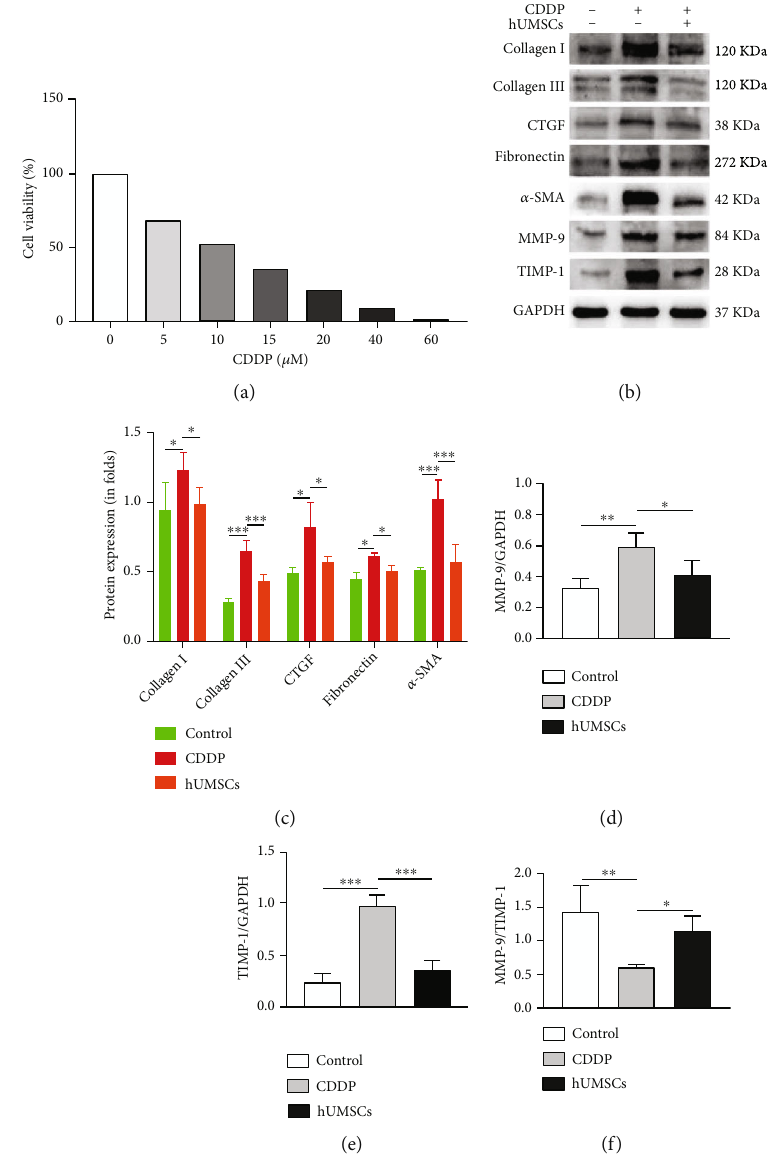
Figure 6: Fibrosis, MMP-9, and TIMP-1 expressions in hEnSCs. (a) Cell viability of hEnSCs as determined in response to varying concentrations of CDDP. (b) Expressions of Collagen I, Collagen III, CTGF, Fibronectin, α -SMA, MMP-9, and TIMP-1 in hEnSCs within each group. A representative blot from one of the three independent experiments performed is shown. GAPDH was used as the loading control. (c) Levels of Collagen I, Collagen III, CTGF, Fibronectin, and α -SMA within each group. (d – f) Levels of MMP-9, TIMP- 1, and MMP-9/TIMP-1 ratio within each group. Data are presented as the means ± SDs . ∗ P < 0 : 05, ∗∗ P < 0 : 01, and ∗∗∗ P < 0 : 001 . CDDP: cisplatin; Collagen I: Collagen Type I; Collagen III: Collagen Type III; CTGF: connective tissue growth factor; α -SMA: alpha smooth muscle actin; MMP-9: matrix metalloprotein 9; TIMP-1: tissue inhibitor of metalloproteinase-1; GAPDH: glyceraldehyde-3-phosphate